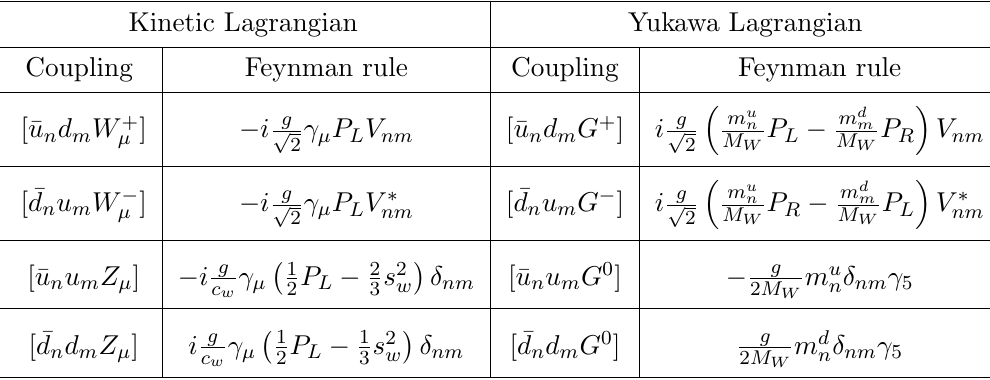
Table 1 . The couplings of the up-type and down-type fermions to the massive gauge bosons and their Yukawa Lagrangian counterparts obtained by substituting the gauge bosons by the corre- sponding Goldstone